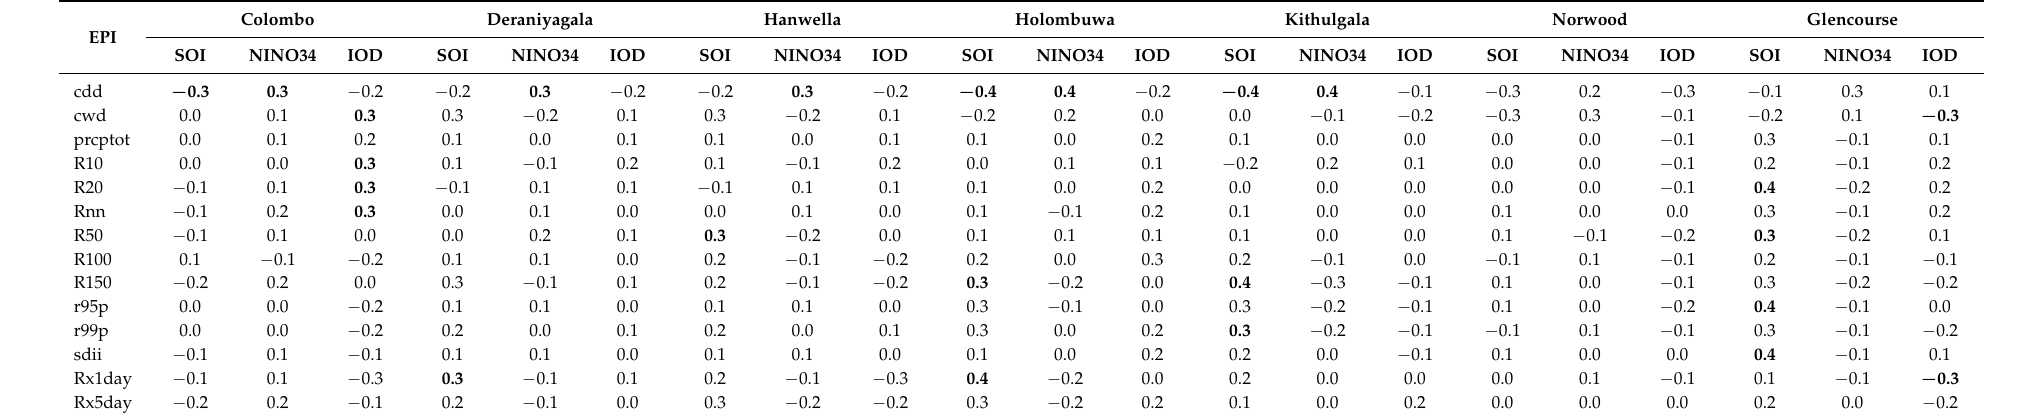
Table 8. Relationship between climate indices and EPIs over the study area (correlation coefficient values at the 0.05 significance